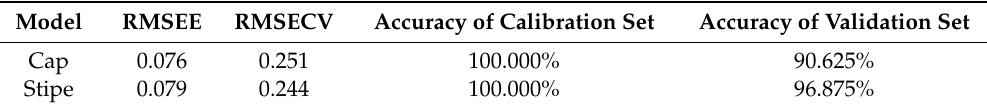
Table 2. Results of PLS-DA models.